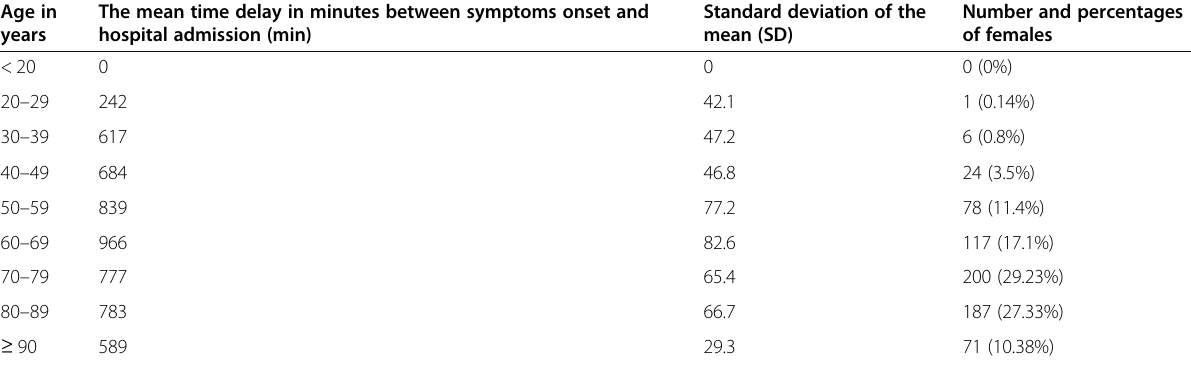
Table 5 It demonstrates delays between onset of symptoms and arrival at the hospital in women of different age groups